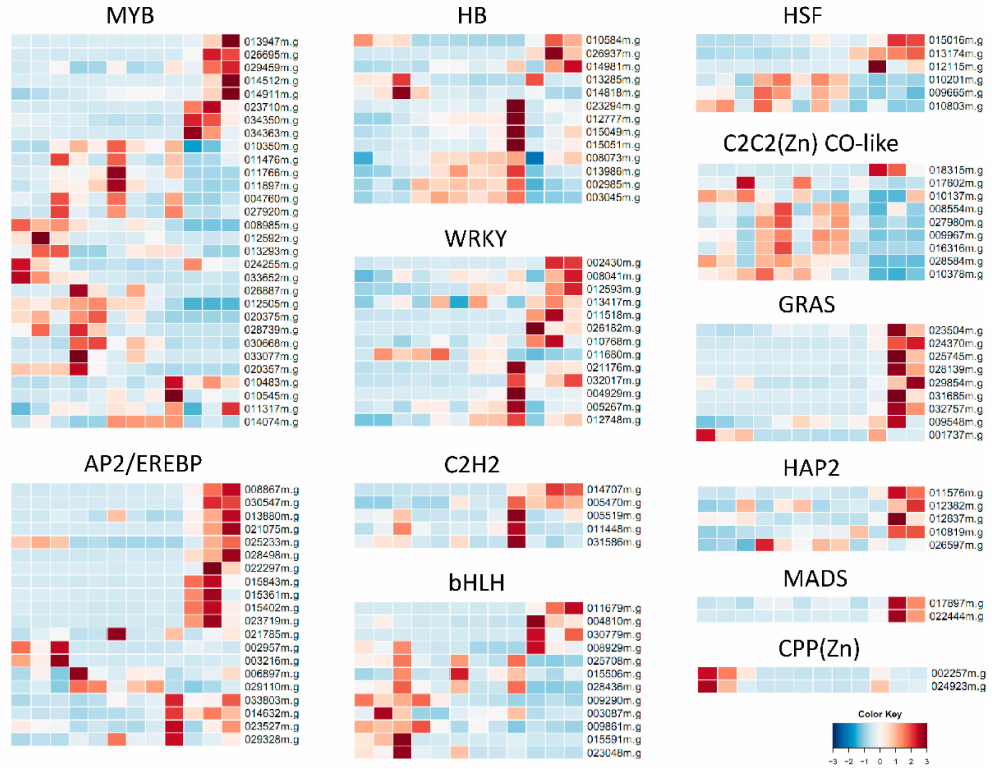
Figure 5. Expression pattern of TFs in cassava leaves and root in response to PEG stress. The samples (from left to right ) in heatmaps were the same as those in Figure